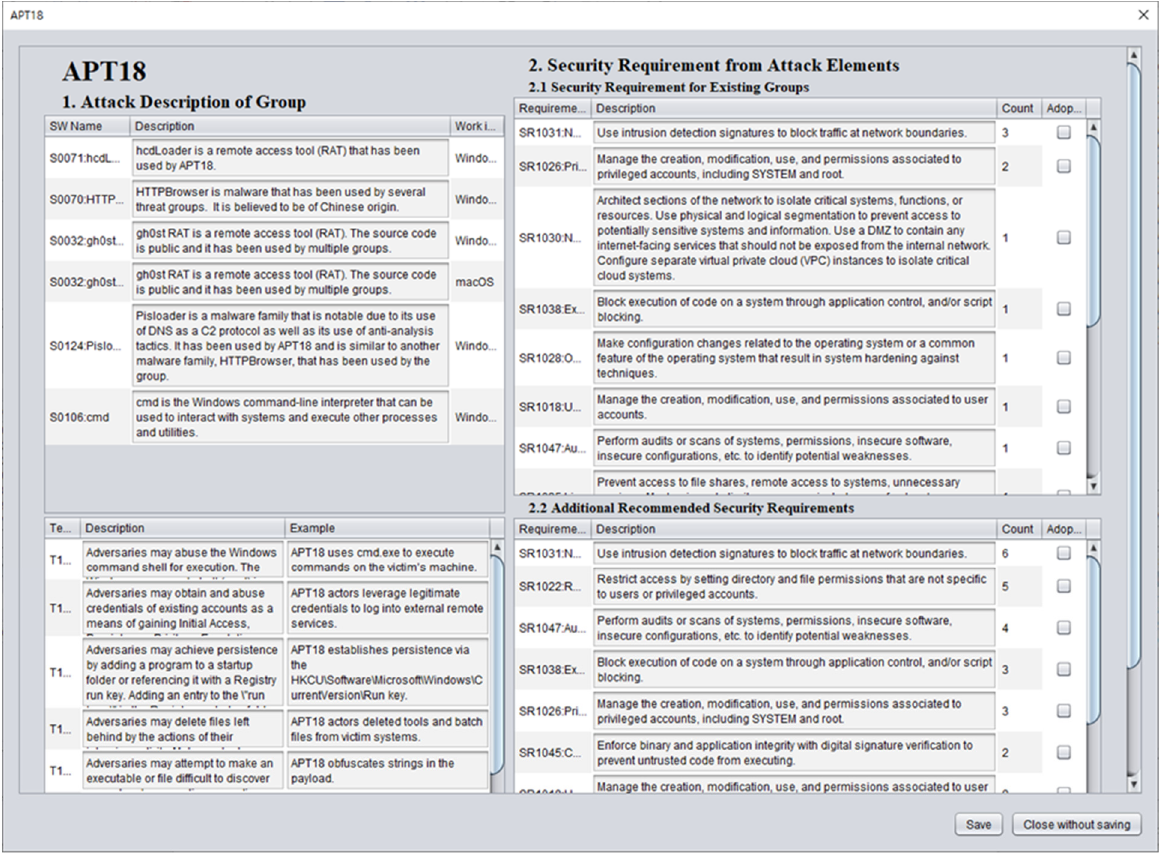
Figure 16. Group information and recommended security requirements.